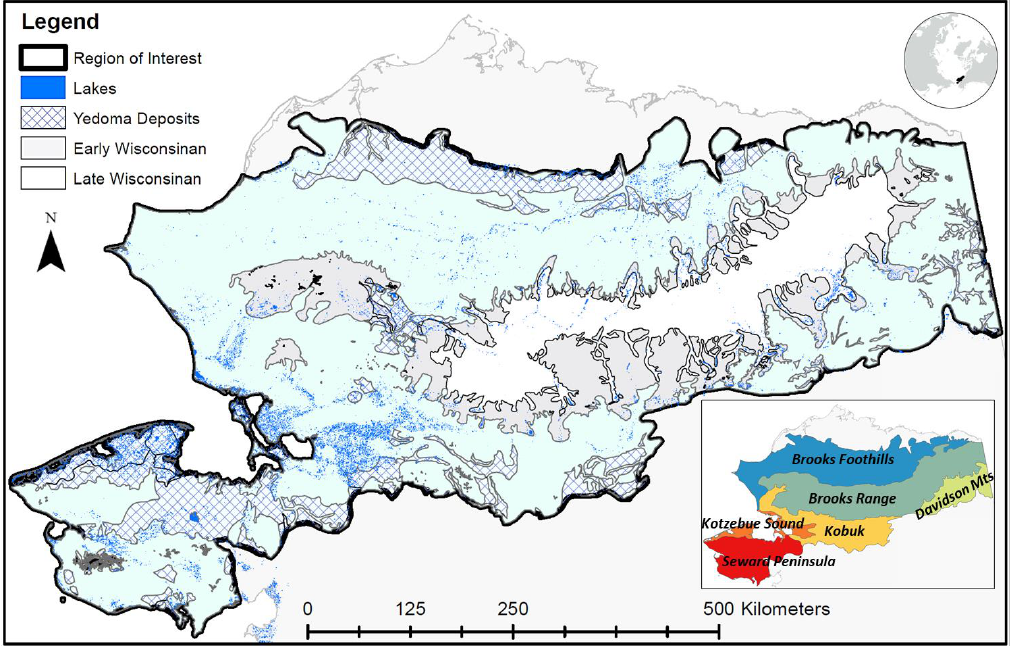
Figure 1. Upland tussock-shrub tundra region of Alaska. The bolded line bounds our region of interest, which includes (i) nearly 35,000 lakes greater than 1 ha in size, (ii) the known yedoma deposits, (iii) the Wisconsinan glacial extent during the last glacial maximum, and (iv) seven ecoregions: Brooks Foothills, Brooks Range, Davidson Mountains, Kobuk Ridges and Valleys, Kotzebue Sound Lowlands, and the Seward Peninsula.